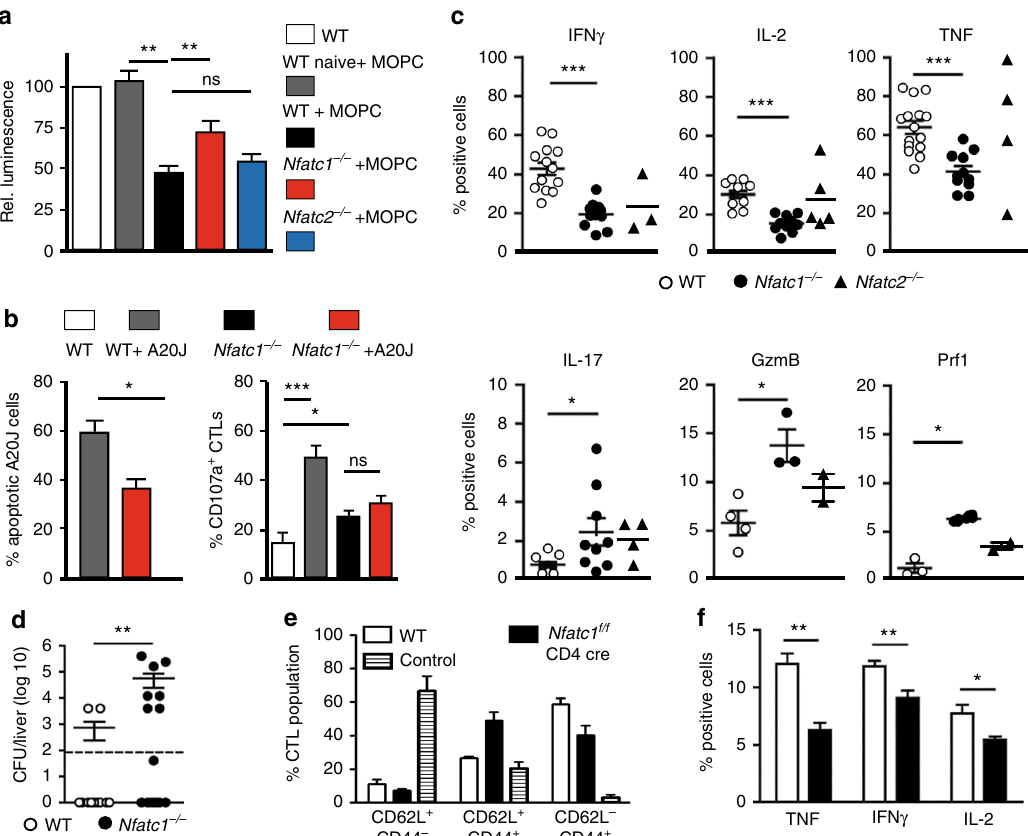
Fig. 2 Defective killing activity of NFATc1-de fi cient aCD8 + Ts and CTLs. a Defective killing of MOPC 315 plasmacytoma cells expressing a luciferase indicator gene by aCD8 + Ts generated upon activation by α CD3/CD28 for 3 d in vitro. WT, Nfatc1 − / − ( Nfatc1 f/f x CD4-cre mice) and Nfatc2 − / − aCD8 + Ts were incubated with MOPC target cells for 24 h. As controls, naive CD8 + T cells were incubated, and WT aCD8 + Ts were incubated without MOPC target cells, and WT aCD8 + Ts were incubated without MOPC target cells. b Defective killing of A20J target cells by Nfatc1 − / − CTLs. WT and Nfatc1 − / − C57/B6 CTLs were generated by incubation with irradiated splenocytes from Balb/c mice for 6 d, followed incubation with A20J Balb/c tumor cells for 2 h (see Supplementary Fig. 3b for details). Left, apoptosis induction of A20J cells is presented. Right, the degranulation of CTLs is shown. c Changes in number of NFATc1-de fi cient CTLs expressing various cytokines, granzyme B ( Gzmb ) or perforin ( Prf1 ). Intracellular cytokine expression of CTLs was measured by fl ow cytometry upon stimulation by T + I for 6 h. Granzyme B and perforin expression was measured without T + I stimulation. d Defective clearance of Listeria monocytogenes upon infection in mice bearing NFATc1-de fi cient T cells. WT and Nfatc1 f/f x CD4-cre mice were infected with 5 × 10 5 CFU Δ ActA Lm-Ova 66 bacteria. 5 d later, the mice were sacri fi ced and Lm titers in livers were determined. e Distribution of splenic CTLs upon Lm infection of WT mice and Nfatc1 f/f x CD4-cre mice. Control, uninfected mice. f Number of cytokine-producing CTLs upon Lm infection in Nfatc1 f/f x CD4-cre mice. Data are shown as means ± SEM. Unpaired Student ’ s t-test was used for